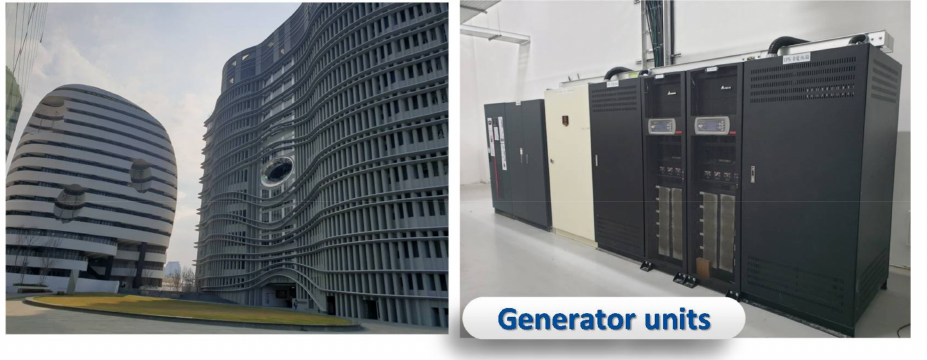
Figure 12. The generator units in the smart buildings of China Medical University in the Shuinan Trade and Economic Park,